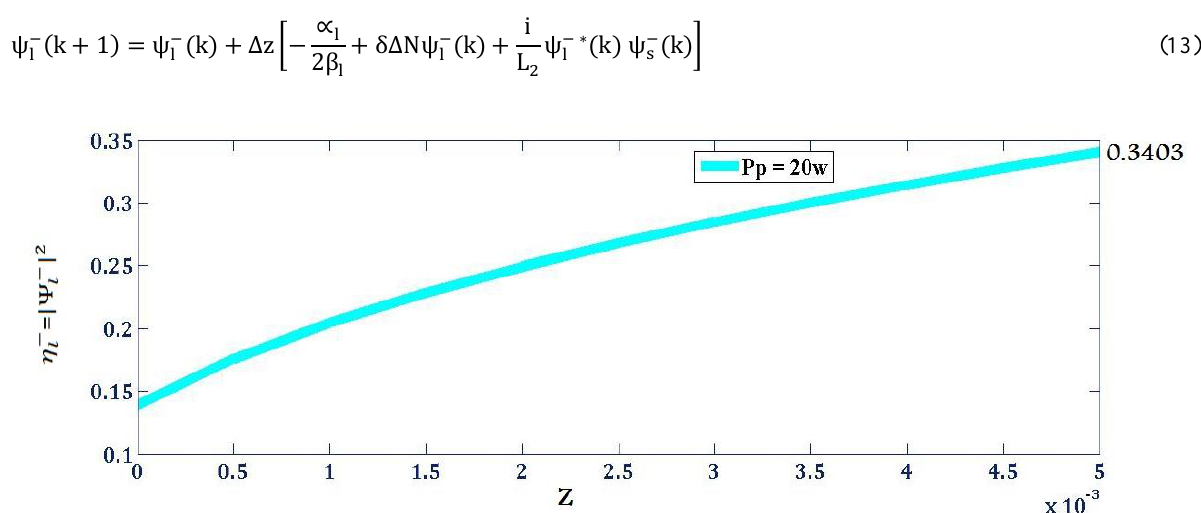
Figure 5. Output efficacy of backward laser beam in z-direction (path